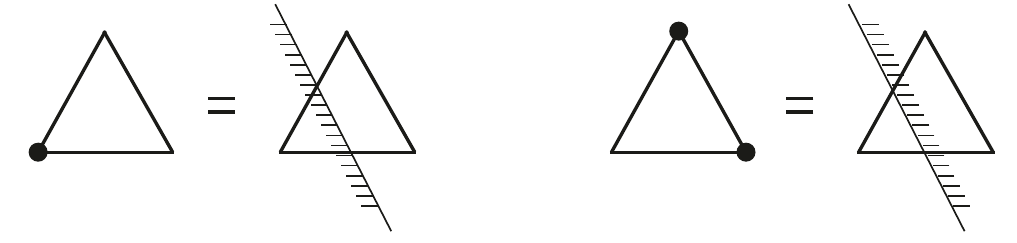
Figure 1 . Marked diagrams and cut diagrams. The shadowed portion stands for T † , the unshad- owed one for T